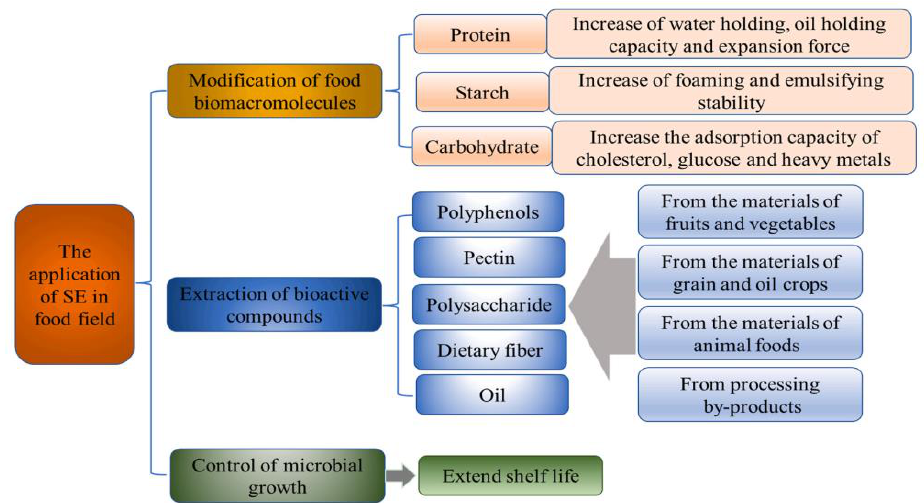
Figure 4. Schematic diagram of action principle of steam explosion [76]. Reproduced with permis- sion from Fachun Wan, Chengfeng Feng, Kaiyun Luo, Wenyu Cui, Zhihui Xia and Anwei Cheng, Trends in Food Science & Technology; published by Elsevier, 2022.